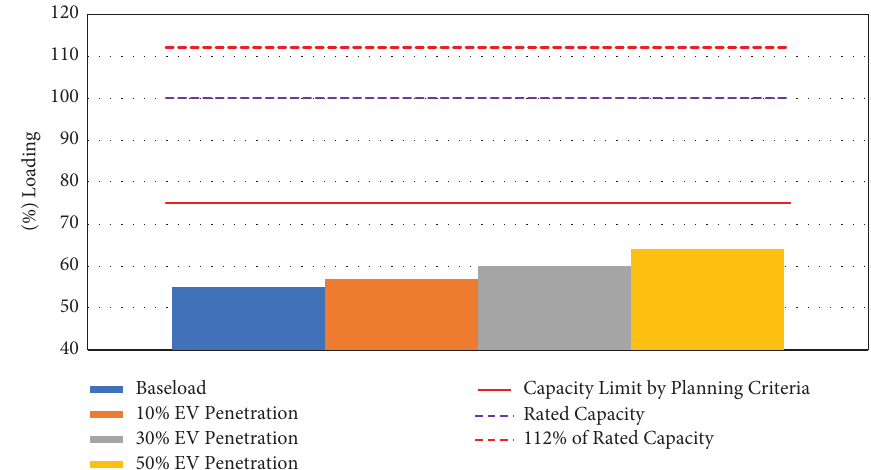
Figure 20: Percent loading of substation transformer under the three scenarios of EV penetration for smart charging.